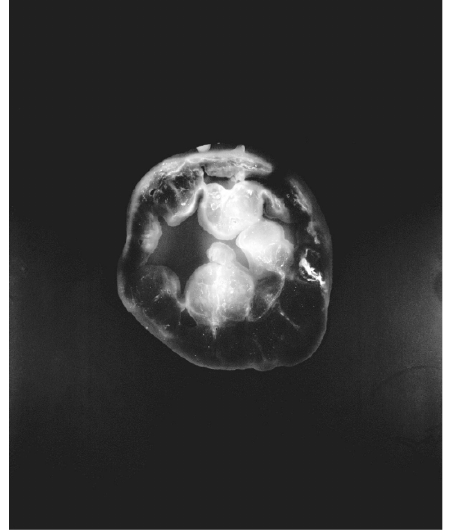
Fig. 2. Susanne Ramsenthaler. From the series Bloom . Photogram on silver gelatine